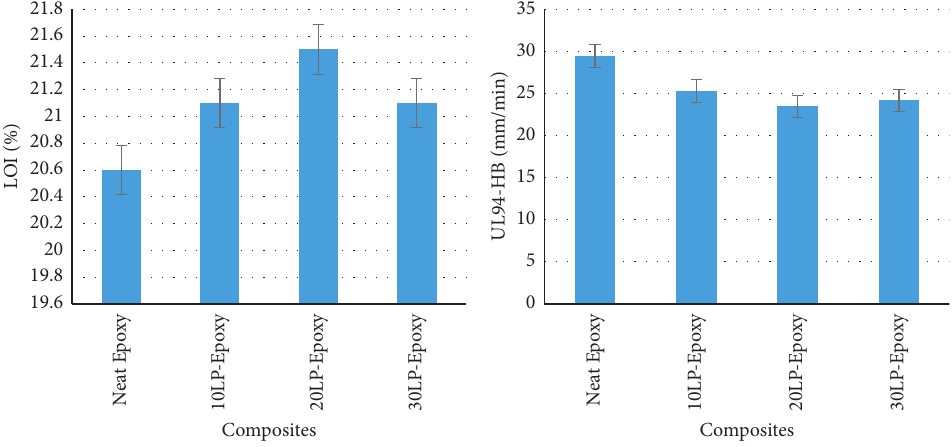
Figure 6: Flame retardant properties of epoxy composites reinforced with litchi peel